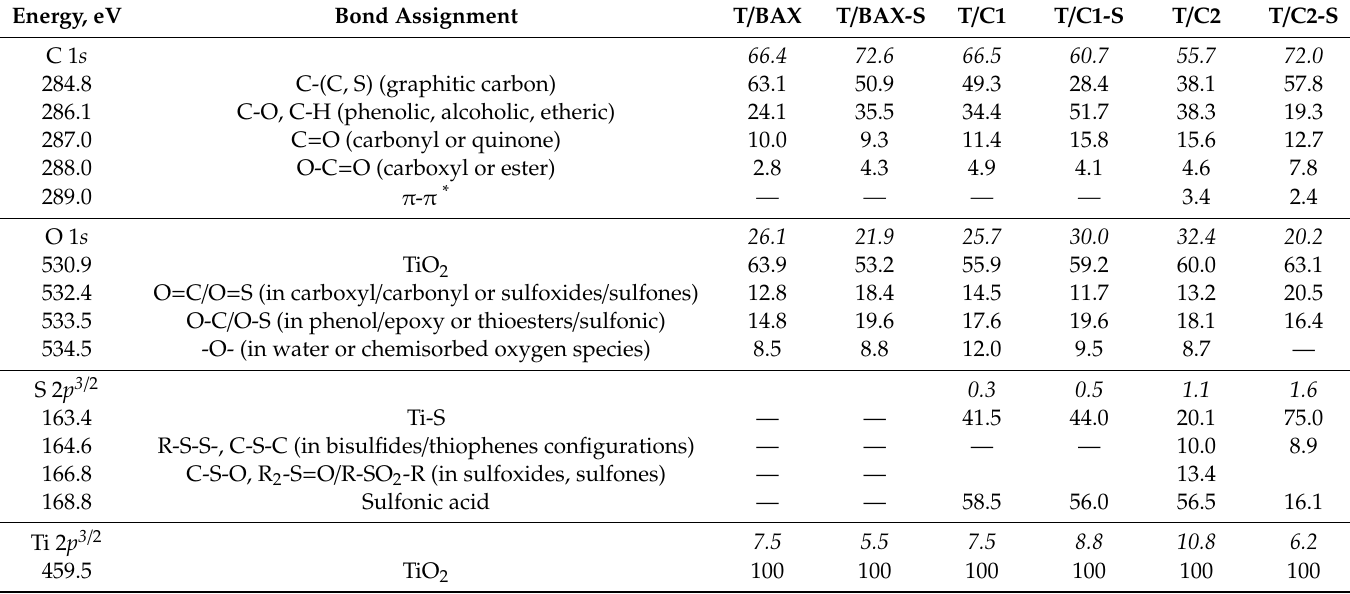
Table 1. Content of elements on the surface (in italic; in at. %) and the results of the deconvolution of C 1s, O 1s, S 2p and Ti 2p 3 / 2 . Energy,